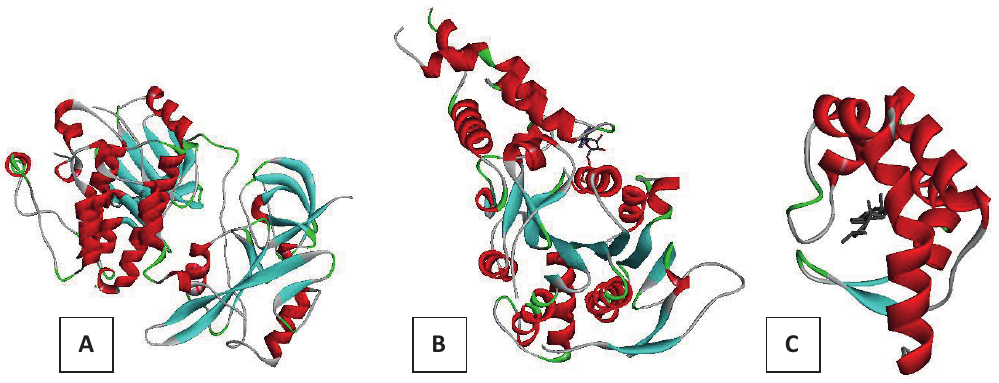
Figure 1 : Crystal structure of (A) hematopoietic cell kinase (2HCK)-quercetin complex, (B) ATPase (2OBM) from the type III secretion system and (C) Beta-cryptogein (1LRI)-cholesterol complex.